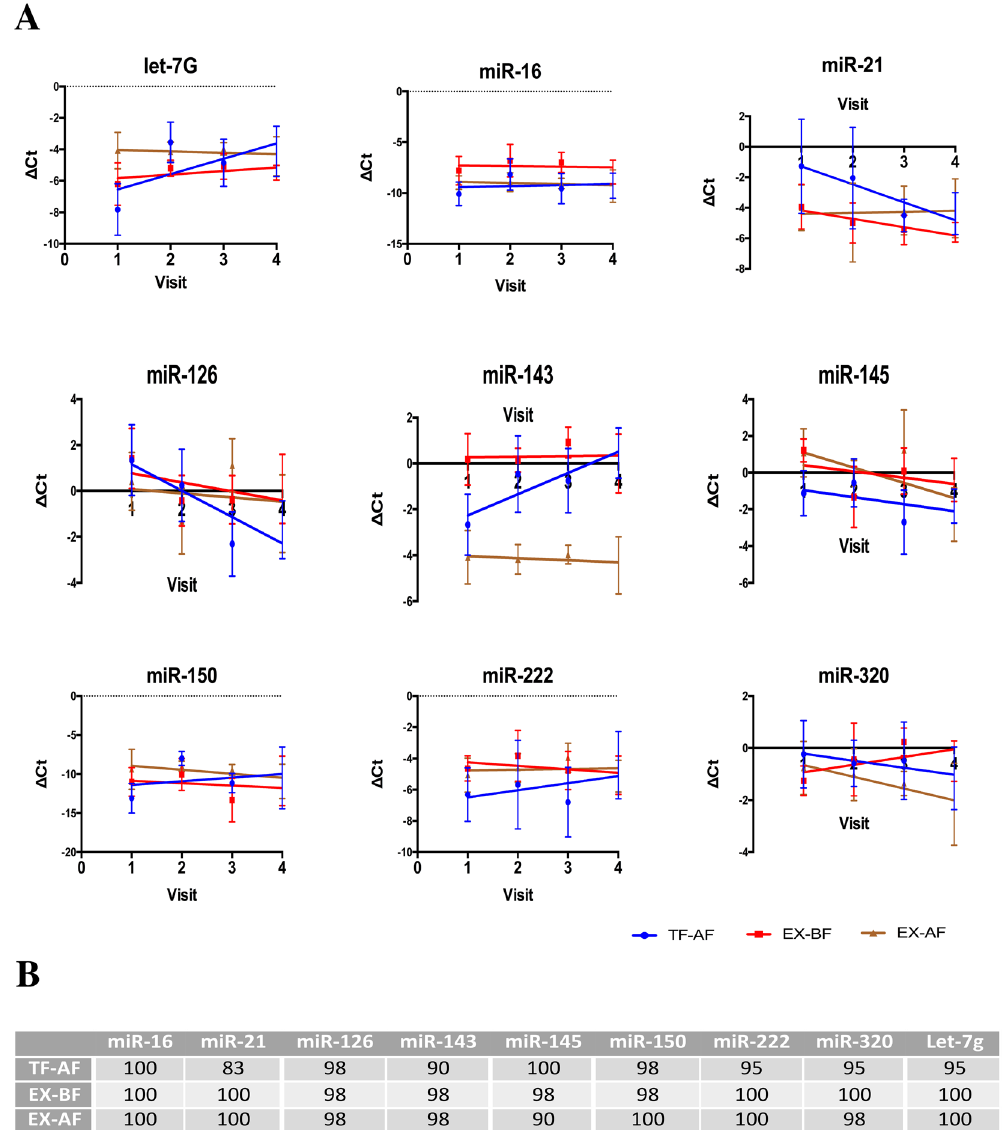
Figure 4. ( A ) Linear regression of Δ Ct values between the 4 consecutive visits (V1; V2; V3; and V4) for the three confident methods (TF-AF; EX-BF; and EX-AF). All the data are presented as the mean ± SD. ( B ) The percentage of visit sample differences is included between the confidence limits of the Bland-Altman test.